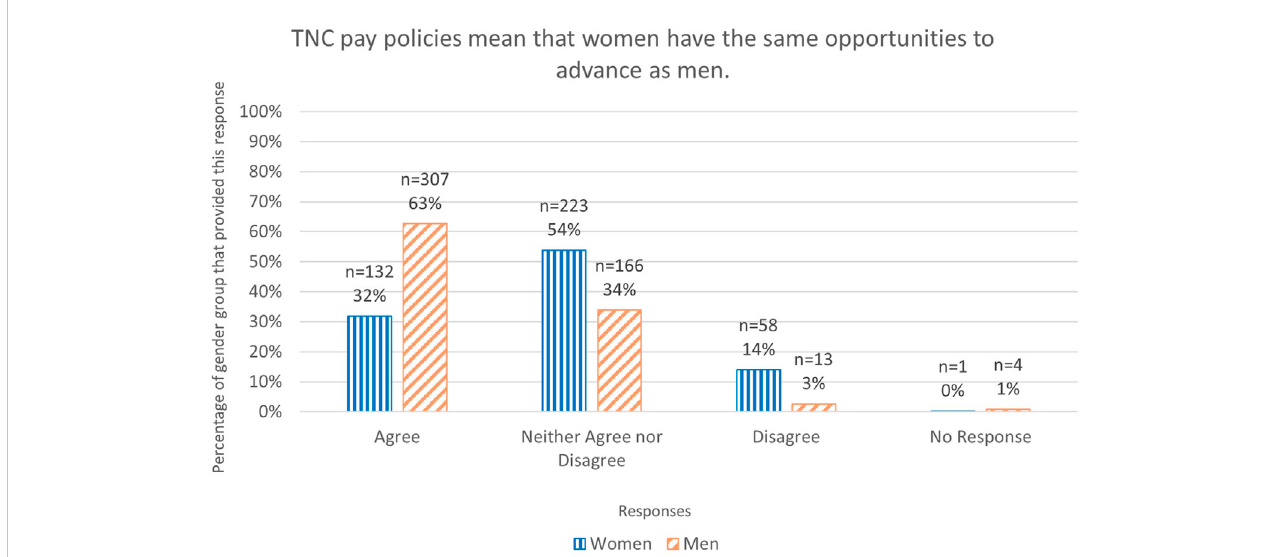
FIGURE 5 Graphof responsesto Q20.TNC paypoliciesmean that womenhave thesameopportunitiesto advance as men. Asapercentageofthetotalnumber of respondents for each